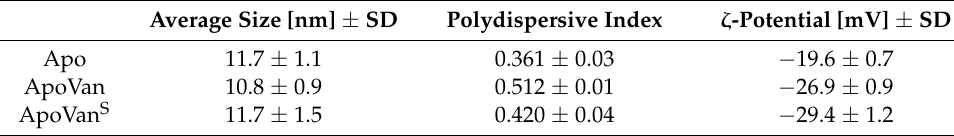
Figure 2. TEM visualization of: ( a ) pure apoferritin; ( b ) the freshly prepared ApoVan; ( c ) the ApoVan stored at 4 °C for a week. Table 1. Average size, polydispersive index and ζ-potential of apoferritin nanoparticles.